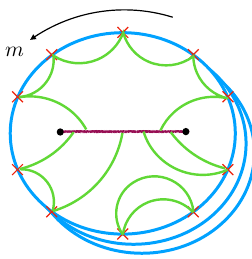
Figure 28 . A part of g 0 corresponding to single block in #( q ∨ t B ) and represented as a surface with respect to g . The boundary represented by the cycles of g B line can be thought of as a “twist operator” which relates the different branches of the